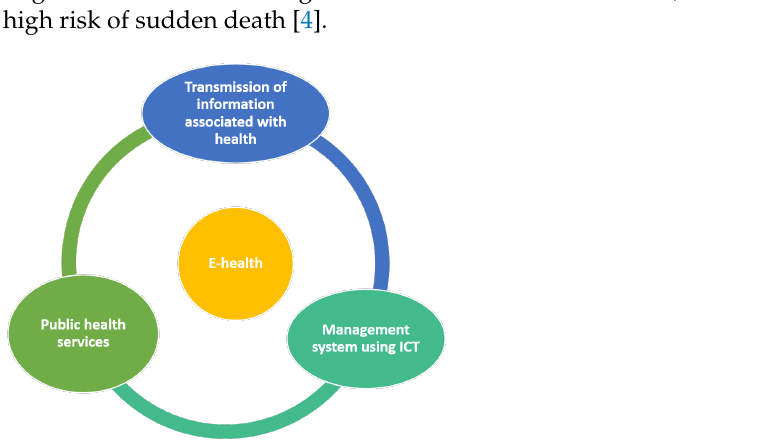
Figure 1. The three pillars for an e-health system proposed by the WHO.